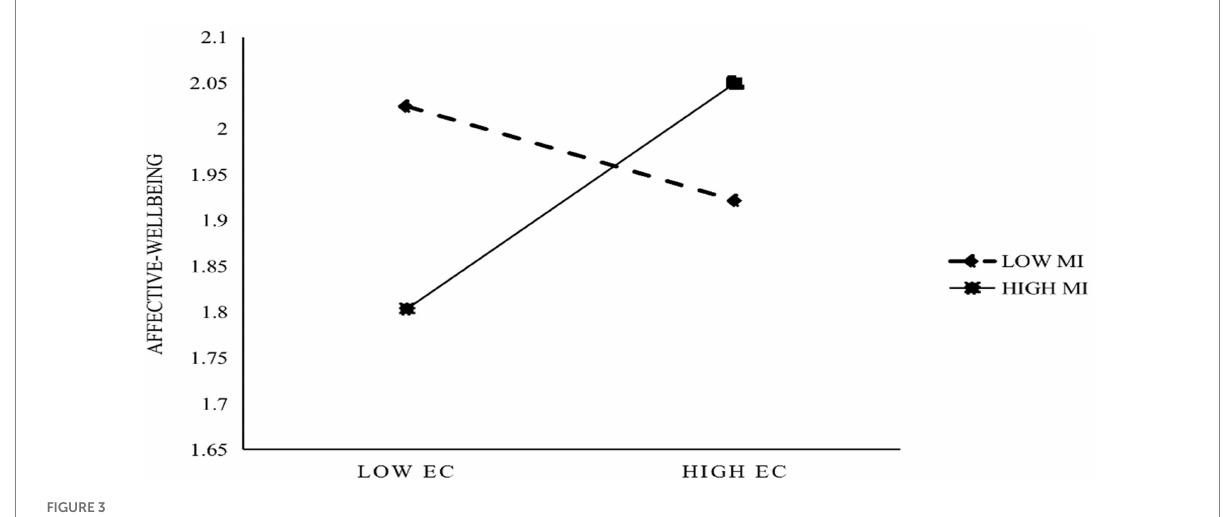
FIGURE 3 Moderation of moral identity in ethical climate and affective